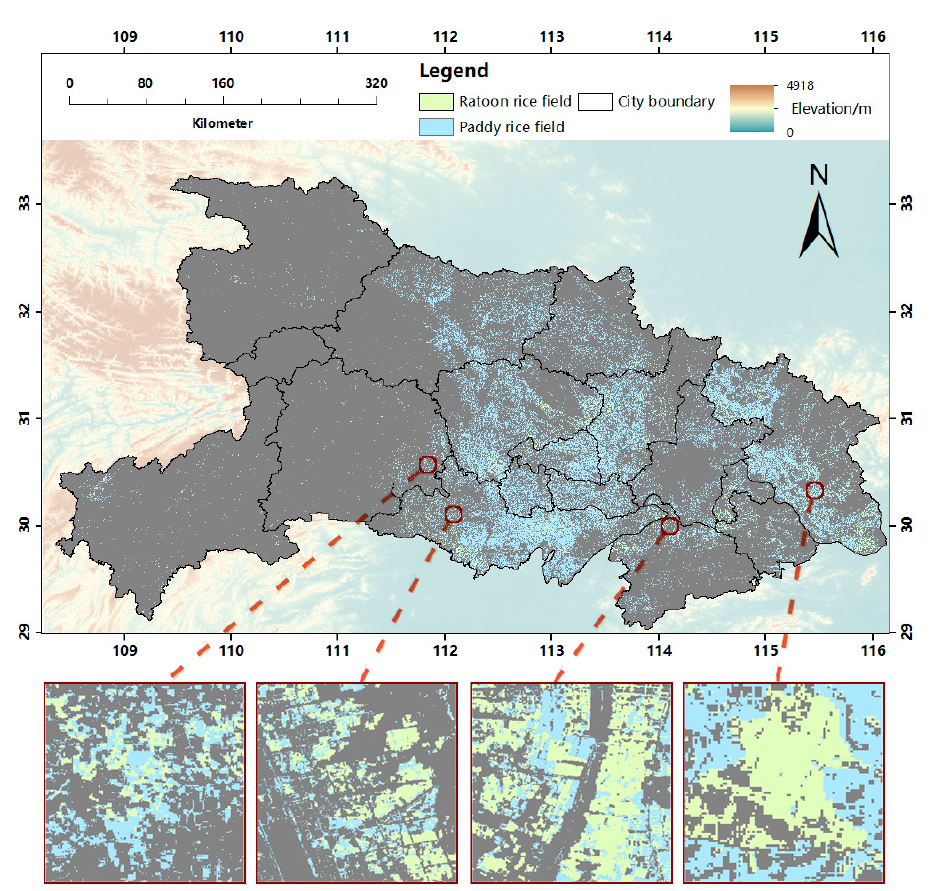
Figure 6. Map of ratoon rice (RR) fields and non-RR paddy rice fields of Hubei Province.